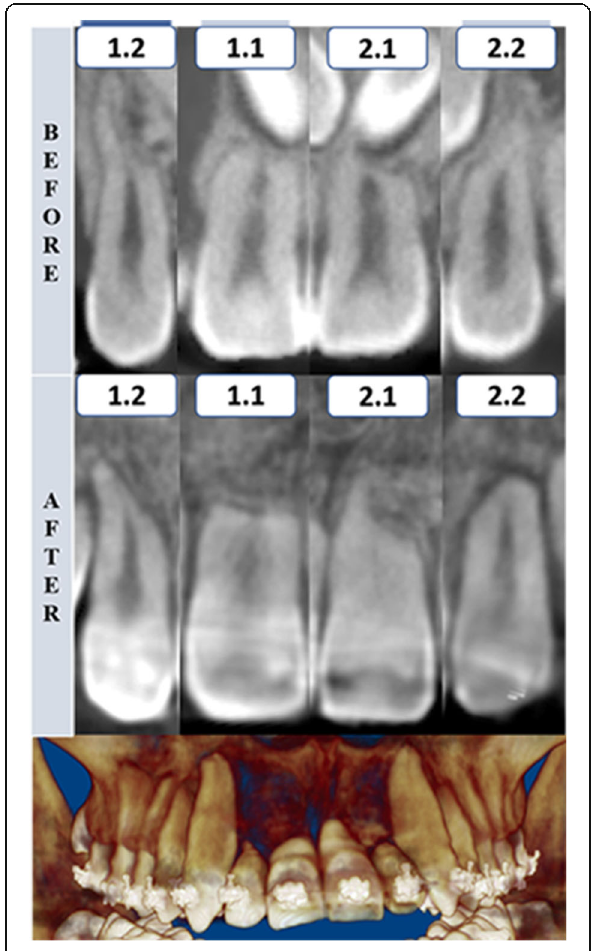
Fig. 6 Tomographic rendering after the canine traction and coronal section of maxillary incisors before and after the impacted canine traction — case 1. 1.2, maxillary right lateral incisor; 1.1, maxillary right central incisor; 2.1, maxillary left central incisor; 2.2, maxillary left lateral incisor